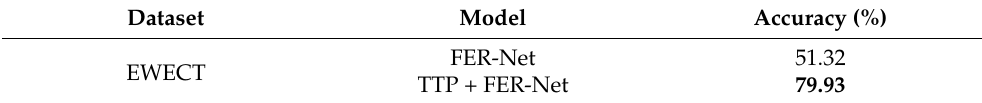
Table 6. Results of ablation experiments on EWECT dataset. (Two classifications: positive,